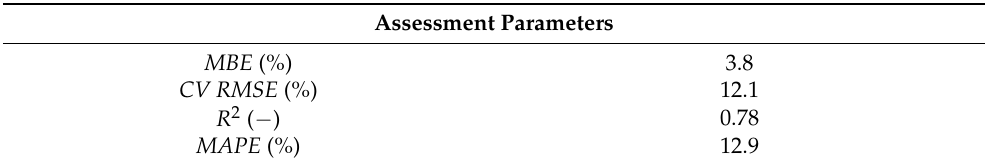
Table 5. Comparison of mean bias error ( MBE ), coefficient of variation root means square error (CV RMSE), coefficient of determination ( R 2 ), and mean absolute percentage error ( MAPE ) values for the analyzed energy consumption